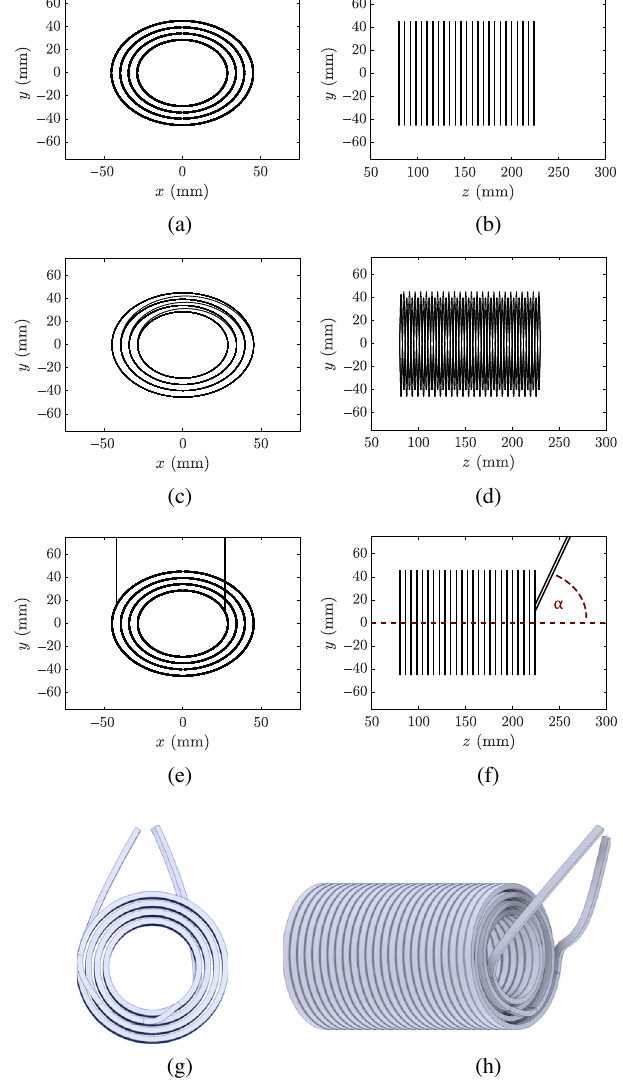
FIG. 3. The different wire geometries of the solenoid magnet that were used in the simulation studies of Sec. III B. (a) Front and (b) side view of the radially symmetric ring wires, (c) front and (d) side view of the connected helix wires, (e) front and (f) side view of the radially symmetric ring wires with connection cables as well as (g) front and (h) side view of the realistic wire